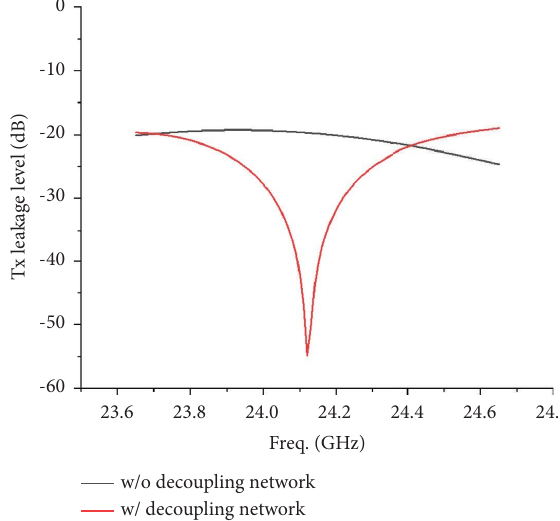
Figure 12: Tx leakage levels of the antennas without and with the decoupling